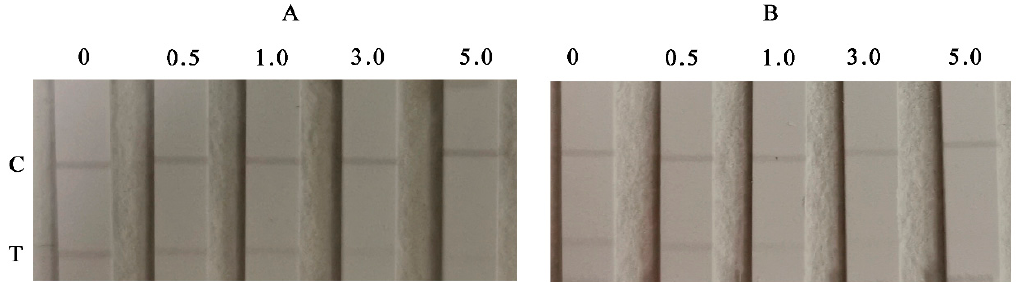
Figure 3. Results of zearalenone (ZEN) detection using AuSP-ICA and AuNRs-ICA strips. ( A ) AuSP ( B ) AuNRs; tested ZEN concentrations in PBS bu ff er (pH 7.4): 0, 0.5, 1.0, 3.0, and 5.0 µ g L − 1 colloidal AuSP ( B ) AuNRs; tested ZEN concentrations in PBS buffer (pH 7.4): 0, 0.5, 1.0, 3.0, and 5.0 μ g L − 1 .